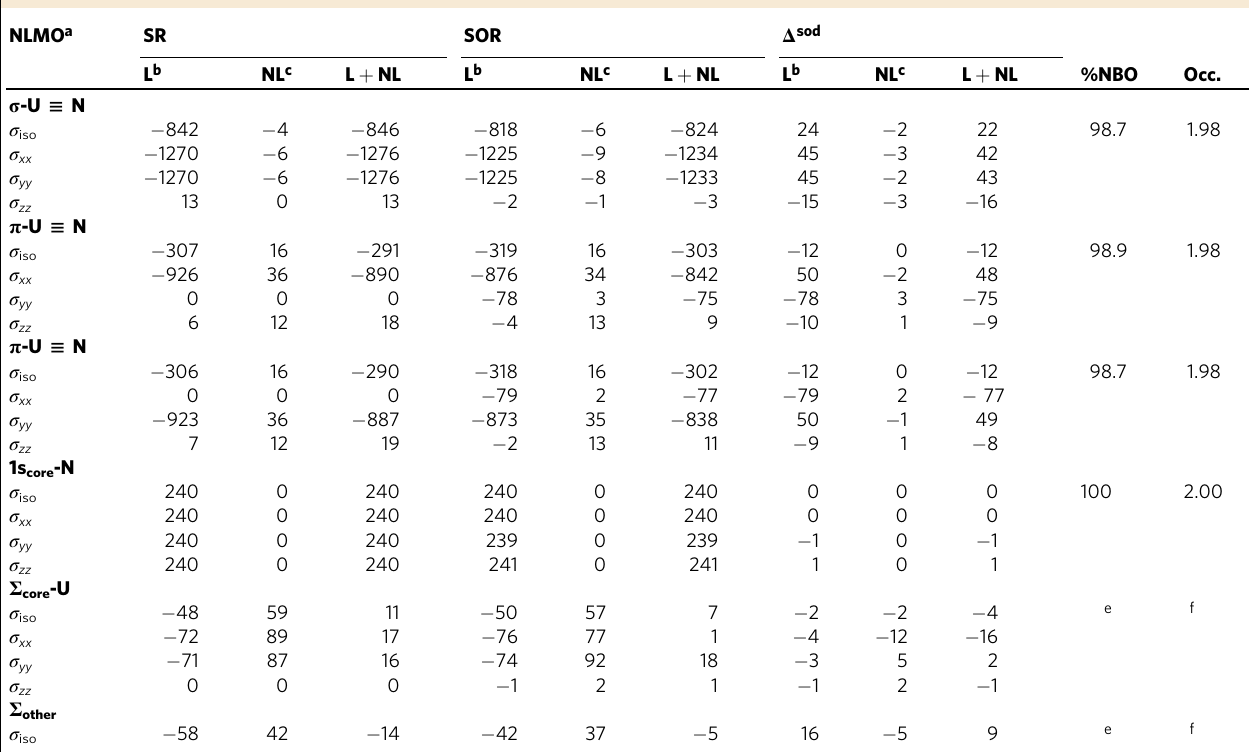
Table 1 Natural localised molecular orbital (NLMO) contributions to the principal 15 N nuclear shielding components ( σ d + [ σ p + σ so ]) of